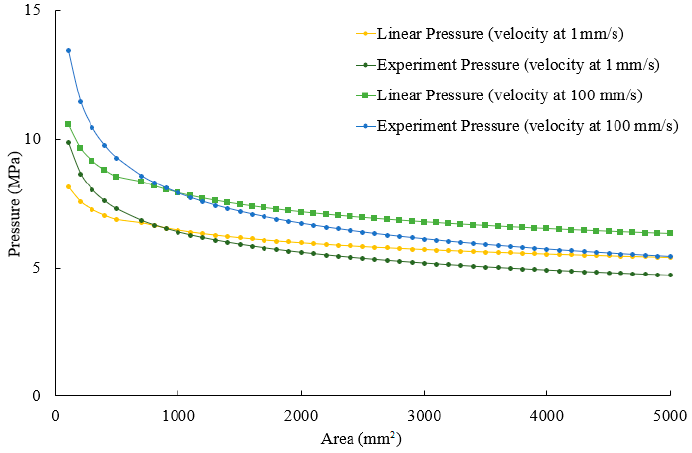
Figure 8. Comparison of pressure-area relationships between simulations and experiments.